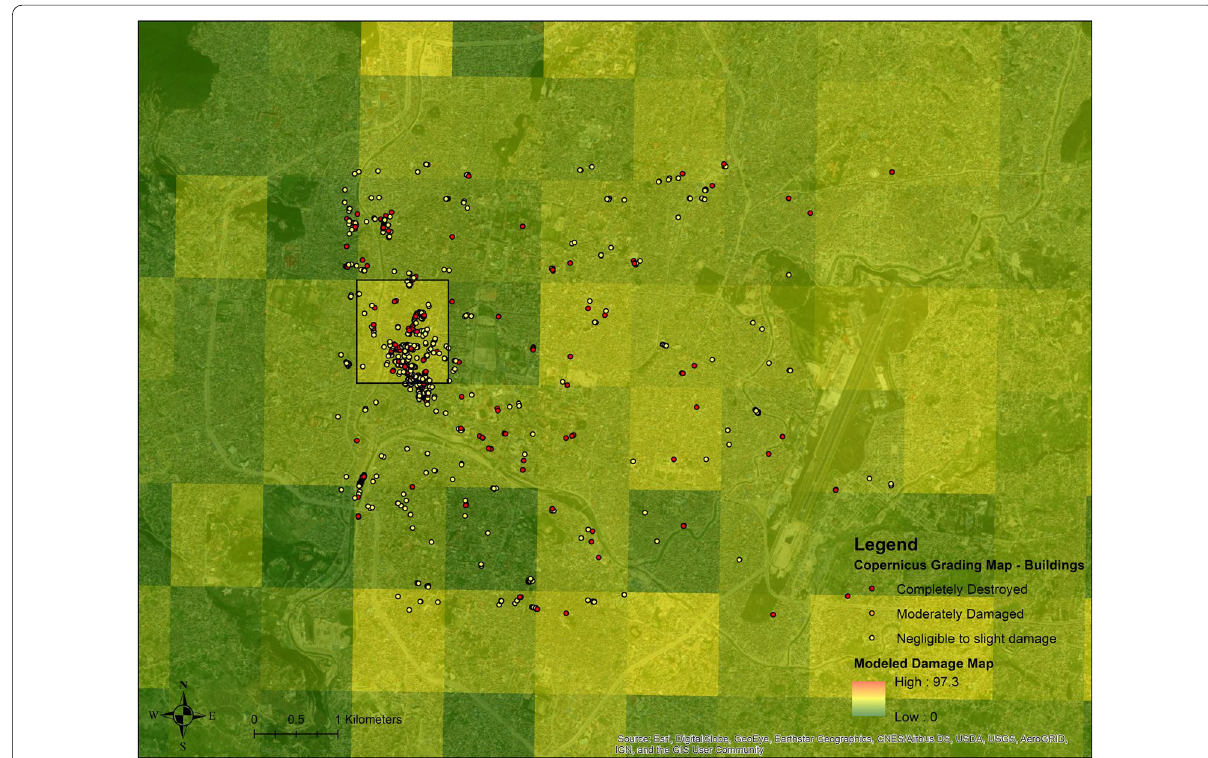
Fig. 8 Comparison for Kathmandu between Copernicus grading map and modelled damage